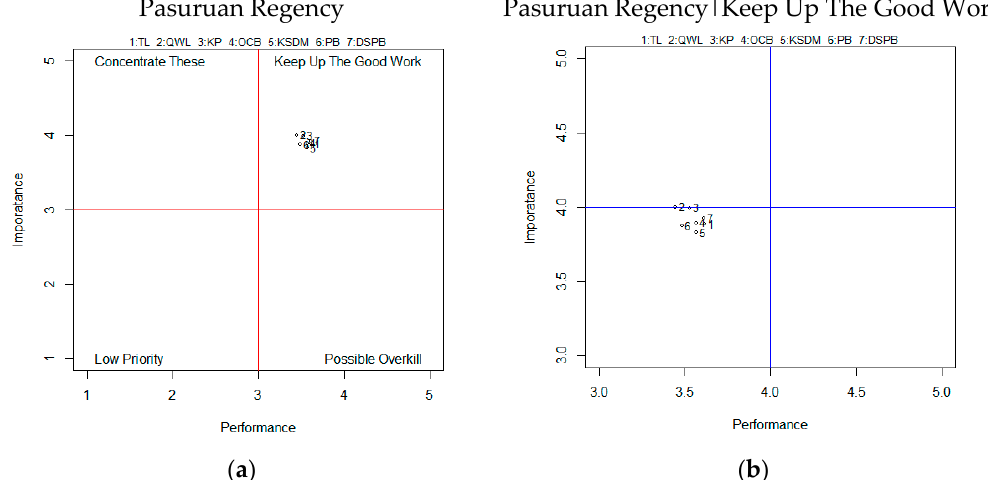
Figure 5. ( a ) IPA Cartesian Diagram of Pasuruan Regency. ( b ) IPA Cartesian Diagram of Keep up the Good Quadrant of Pasuruan Regency